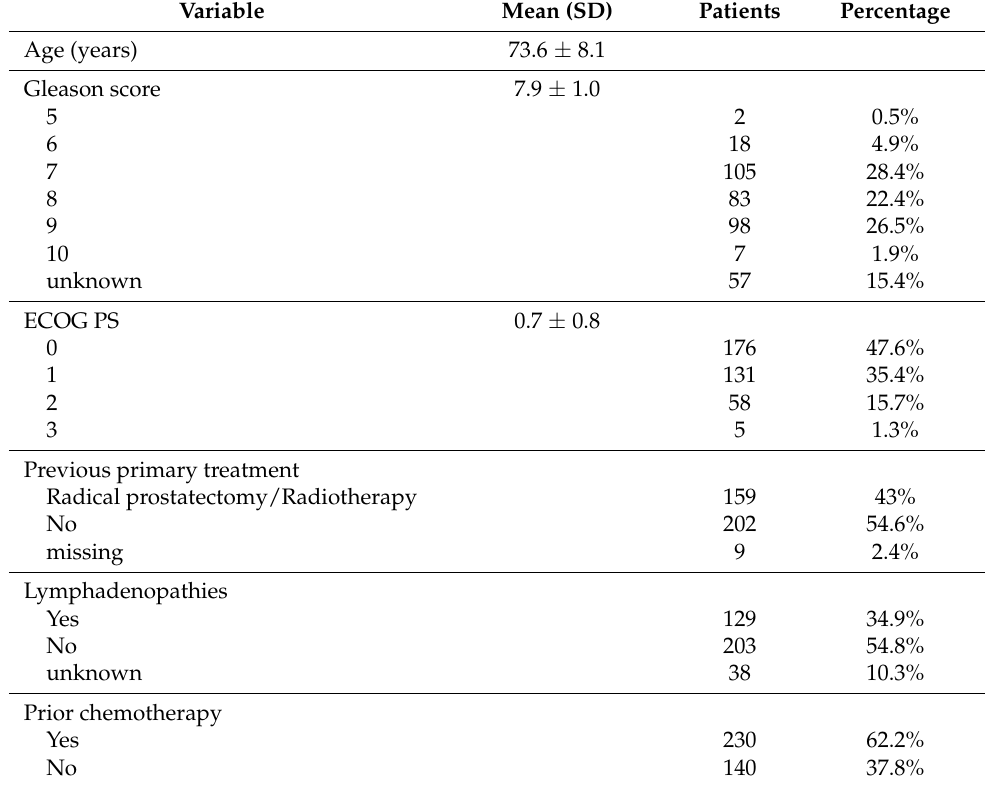
Table 1. Baseline patients’ characteristics (n =